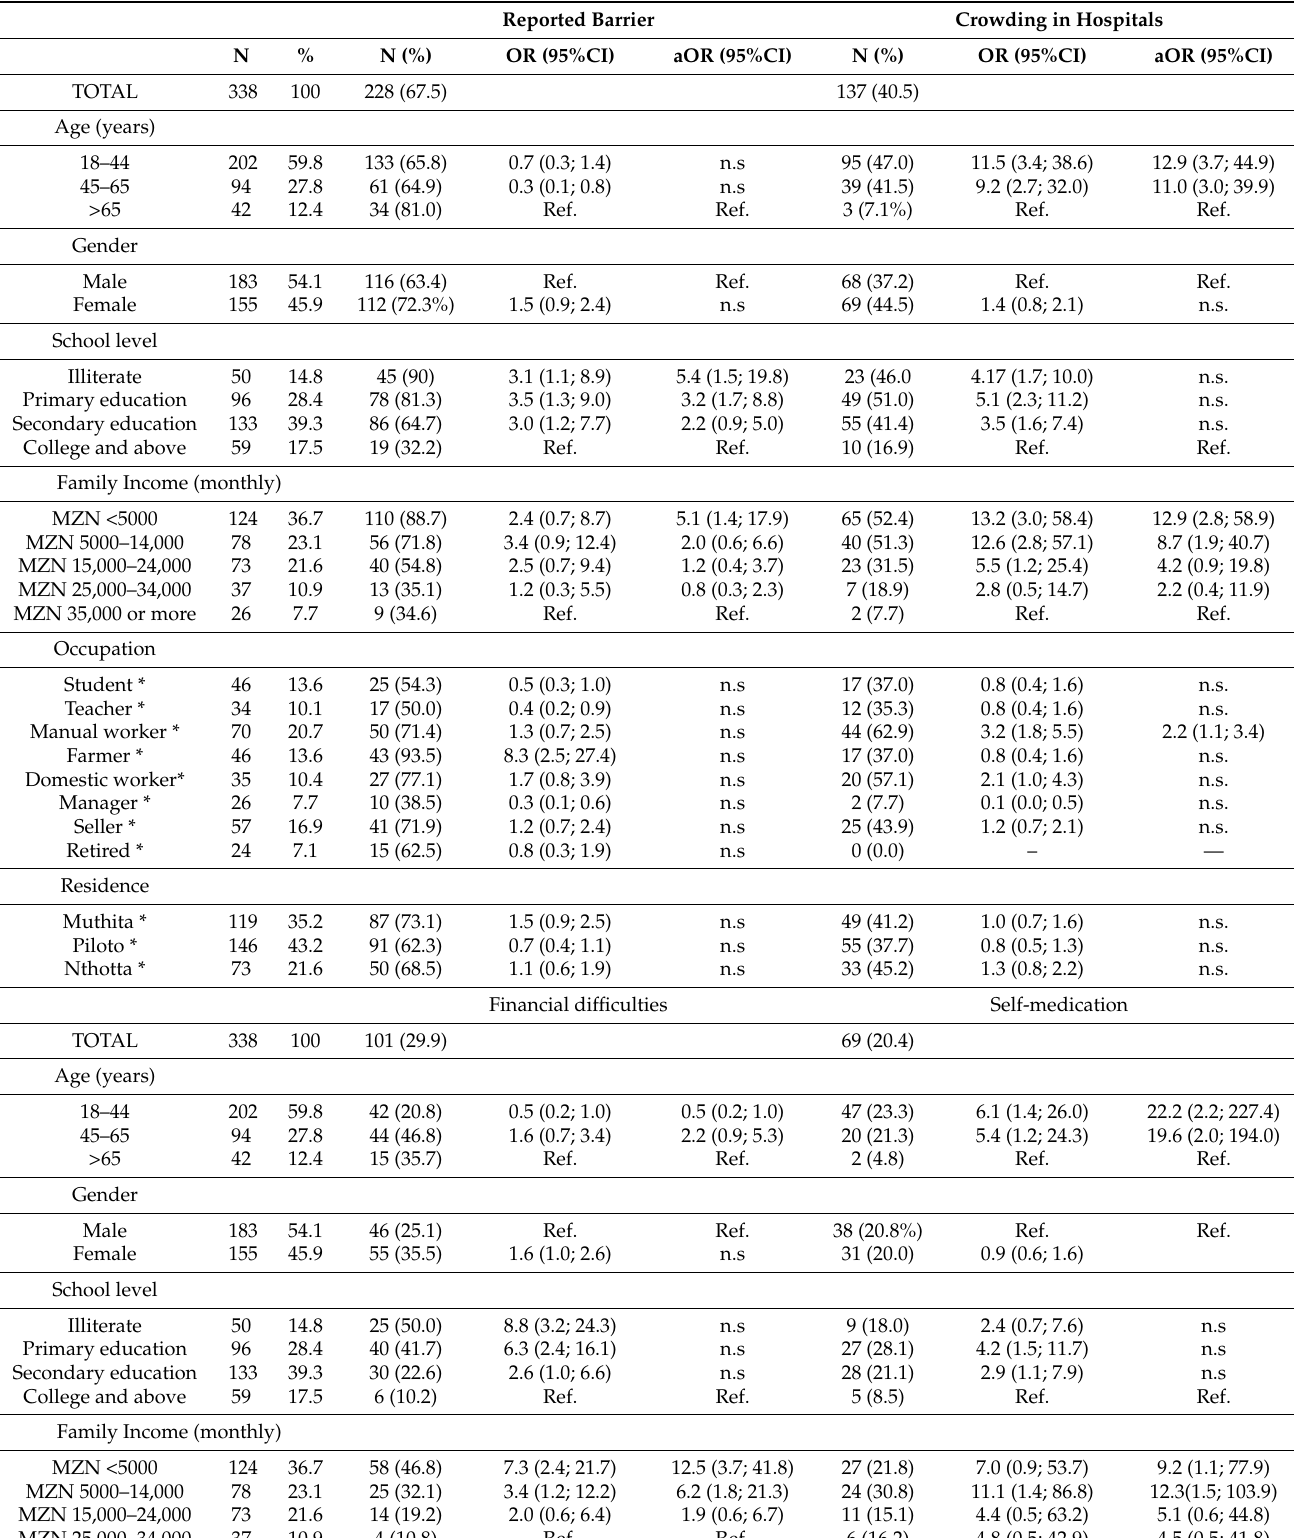
Table 2. Barriers to accessing eye health services and associated factors. Reported